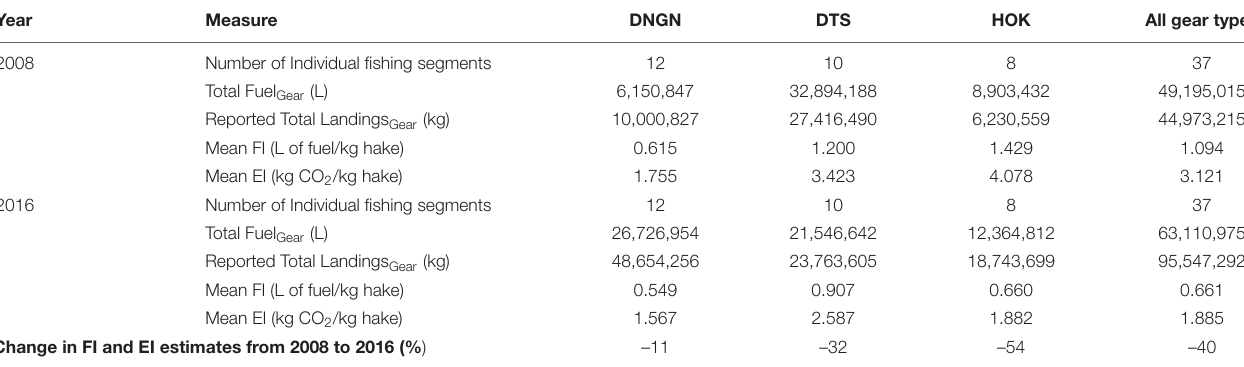
FIGURE 2 | Boxplot of individual Fuel Intensity (FI) estimates for 2008 and 2016, grouped by gear type, where each data point represents an FI estimate for a particular fishing fleet segment, calculated according to Equation (2). Sample sizes for each gear type (i.e., the total number of fishing segments using that gear), in either year, are all equal to or greater than n = 8, and are listed in Table 2 . DNGN, polyvalent-, drift-, or fixed-net gear types; DTS, demersal trawlers and seiners; HOK, vessels using hooks. TABLE 2 | The reported total landings and estimated total fuel, mean Fuel Intensity (FI), and mean Emission Intensity (EI) for hake landed by vessels equipped with particular gear types (DNGN, HOK, DTS, or all gear types) in years 2008 and